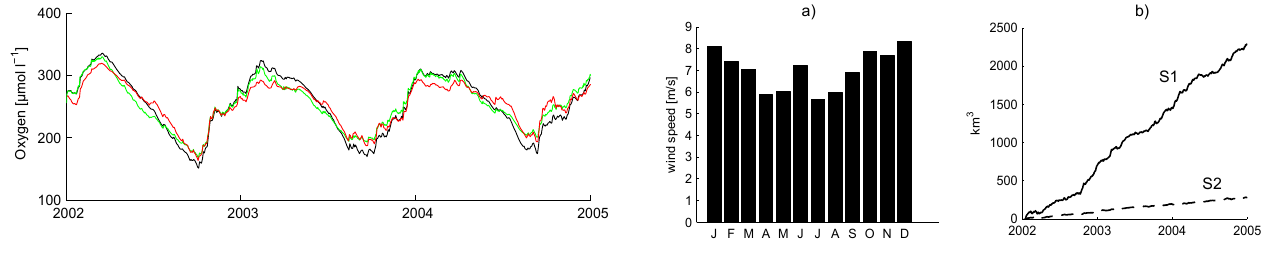
Fig. 7. (a) Monthly mean wind speed during the three years 2002– 2004. (b) Integrated southward water transport below 15m through the two sections S1 and S2.